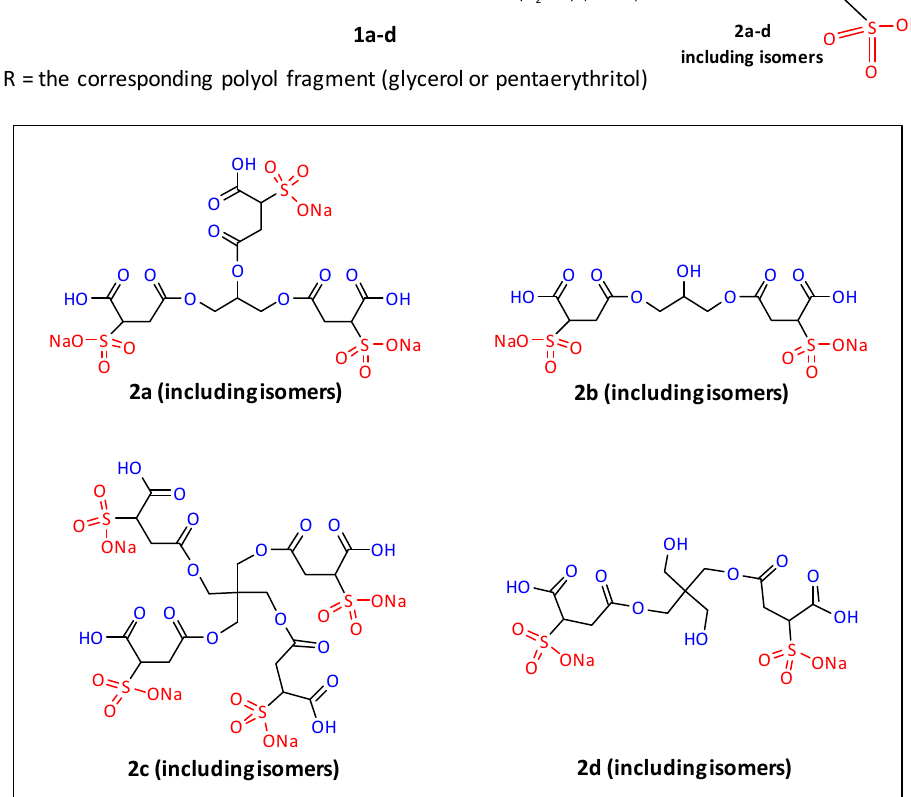
Figure 1. Synthesis procedure of sulfonated alcohols.